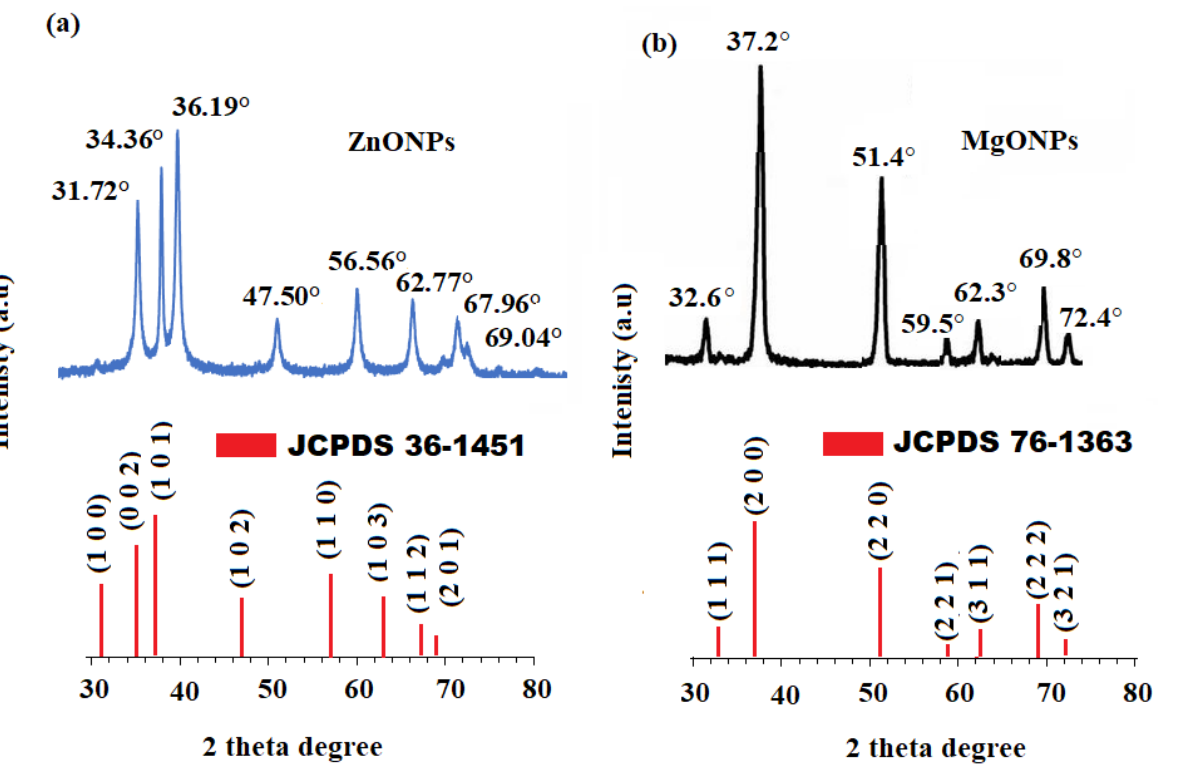
Figure 5. The XRD patterns of the ( a ) ZnONPs and ( b ) MgONPs detected in the range 30–80 theta degrees. The Scherrer formula was applied to estimate the average crystallite size using the dominant peak in the XRD